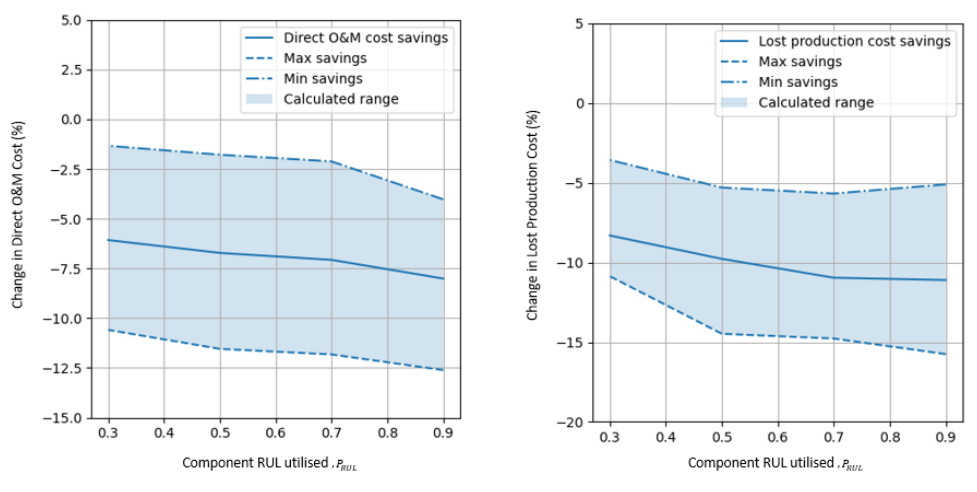
Figure 4. Percentage cost reduction in predictive maintenance